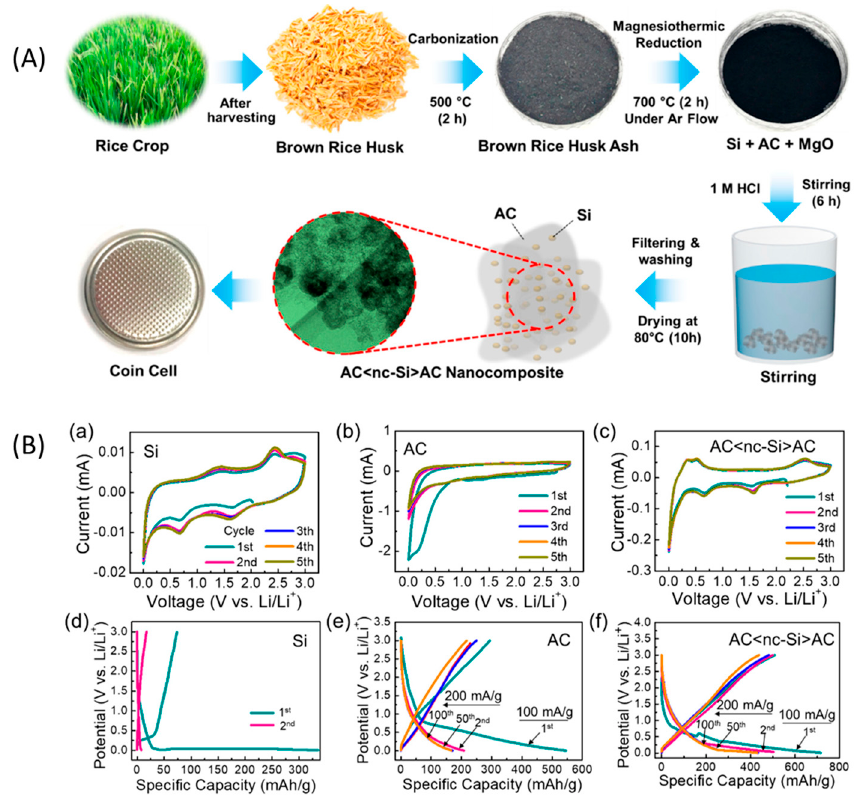
Figure 4. ( A ) Preparation of activated carbon/silicon nanocrystals composite materials and ( B ) cyclic voltammetry and galvanostatic charge–discharge (GCD) curves of the materials prepared. Adapted from MDPI [106]. from MDPI